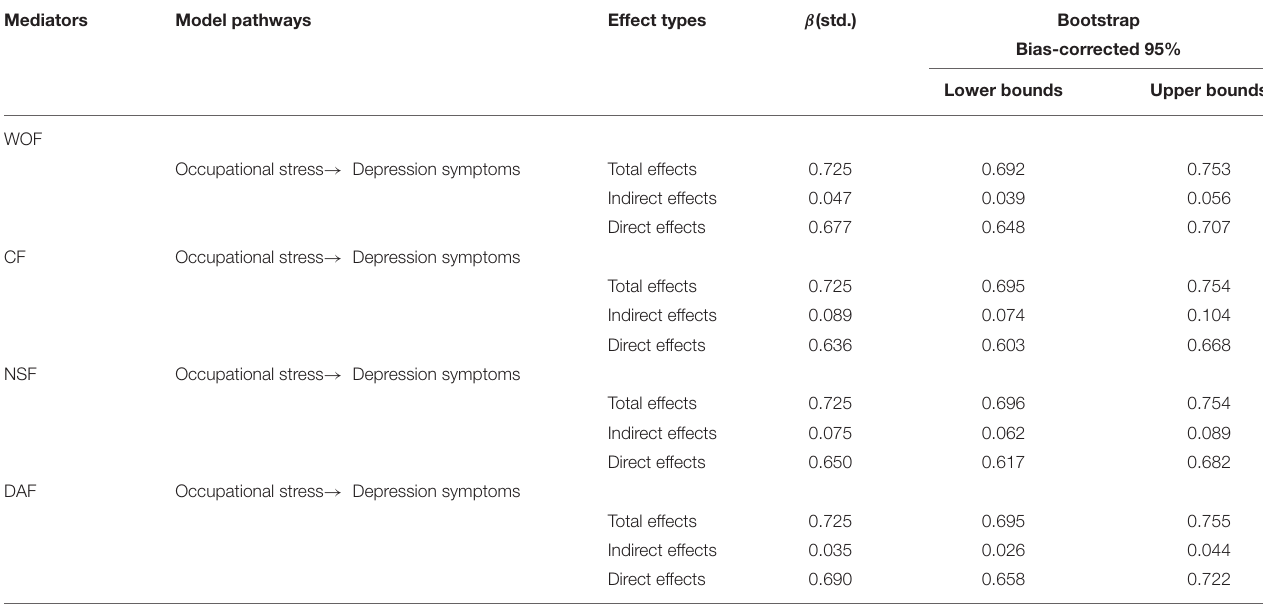
TABLE 4 | Mediating role of WOF or WOF types on the associations between occupational stress and depression